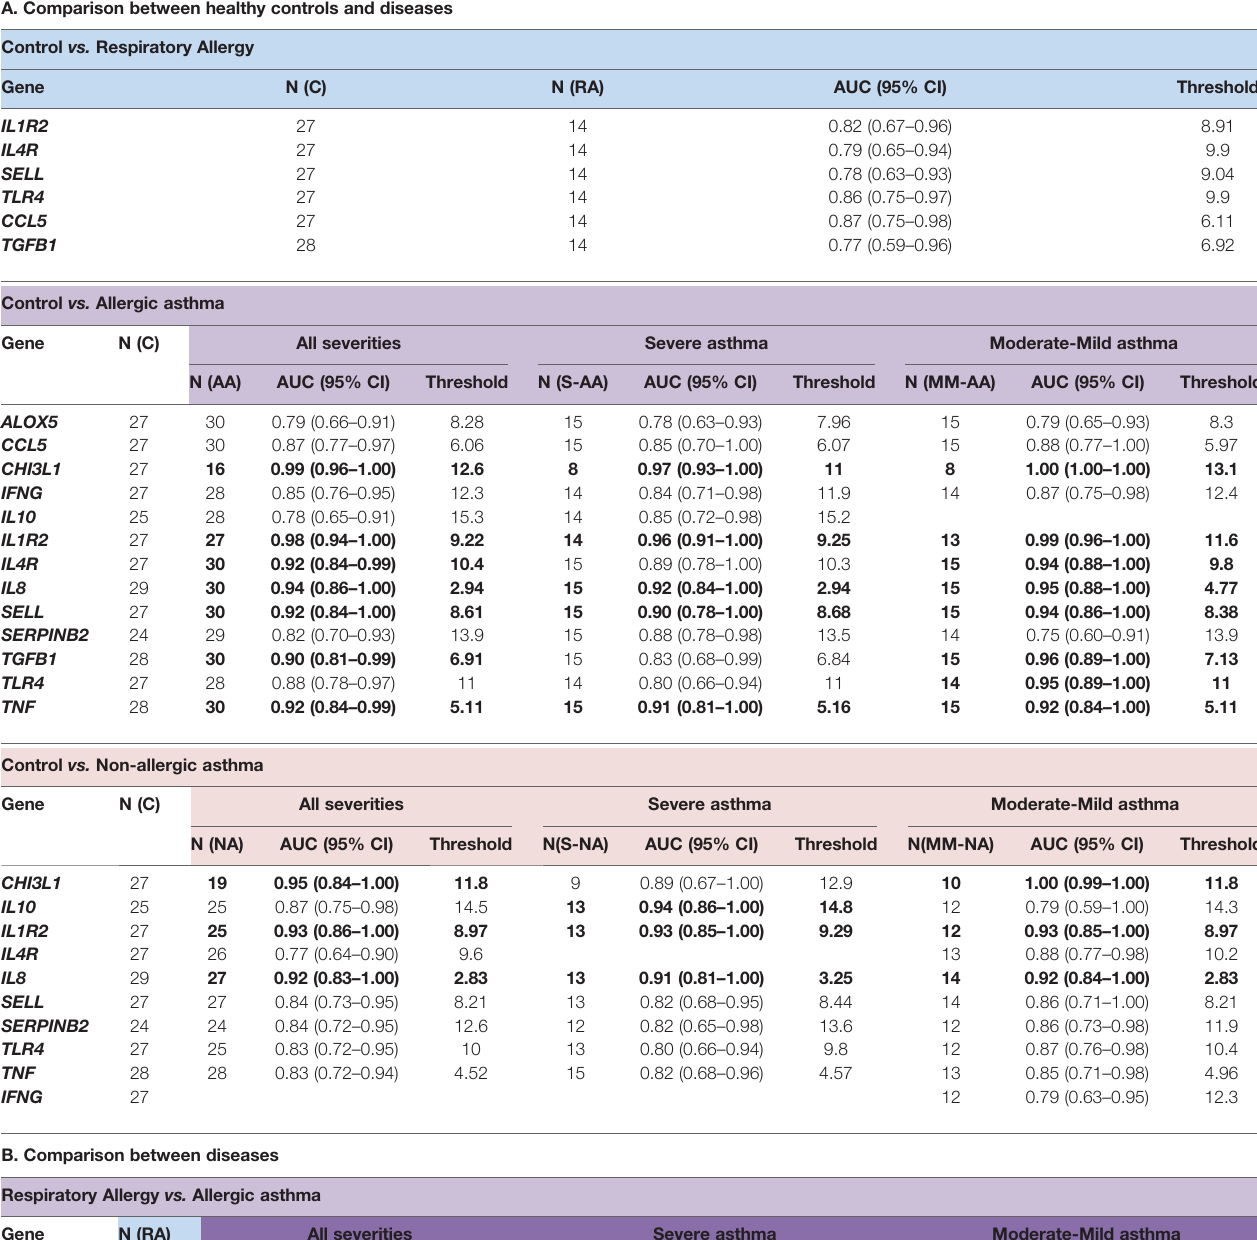
TABLE 7 | ROC analysis of gene expression in the 13 common proteins de fi ned by systems biology and experimental data. A. Comparison between healthy controls and diseases Control vs. Respiratory